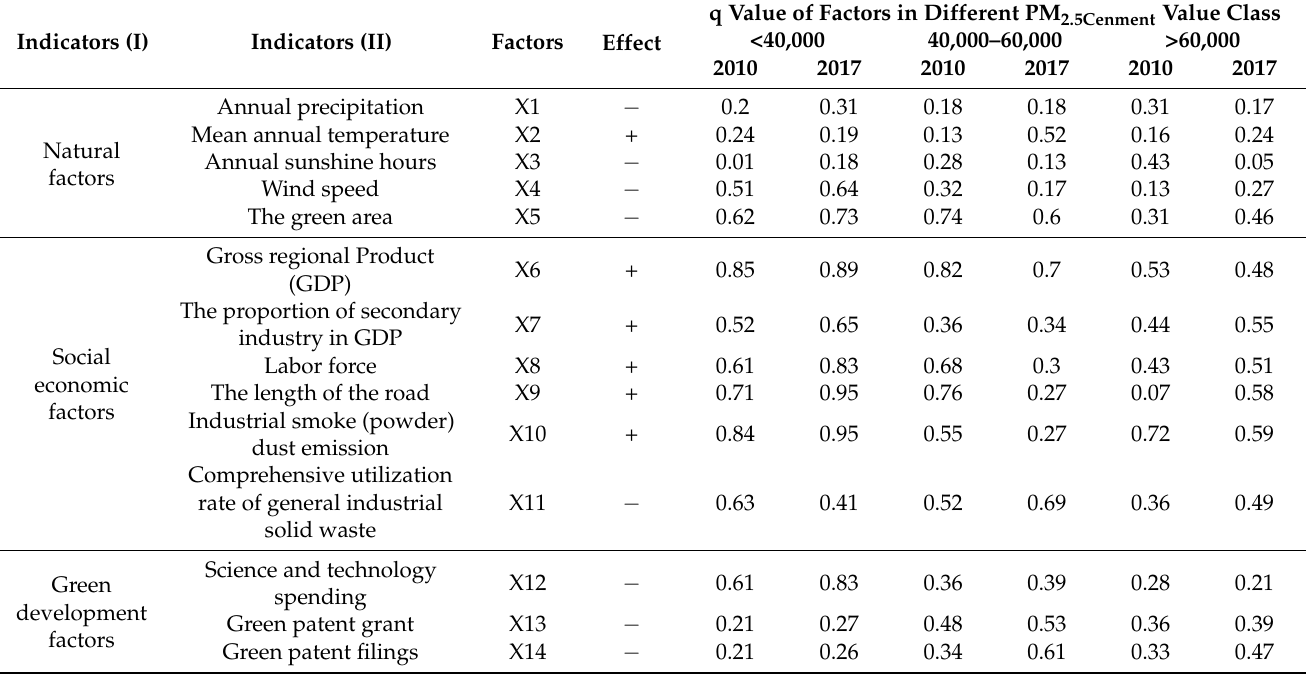
Table 3. Differentiation and factor detection from the Geographic detector model. The Effect (+/ − ) was the promoting or inhibiting